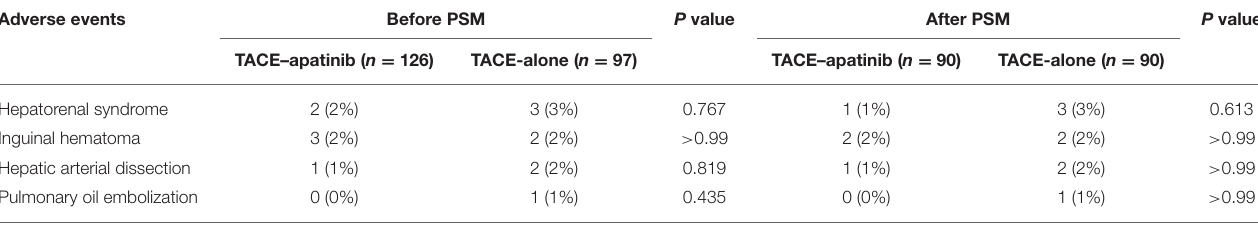
TABLE 2 | Adverse events related to TACE from the second TACE procedure in the two groups before and after PSM analysis. Adverse events Before PSM